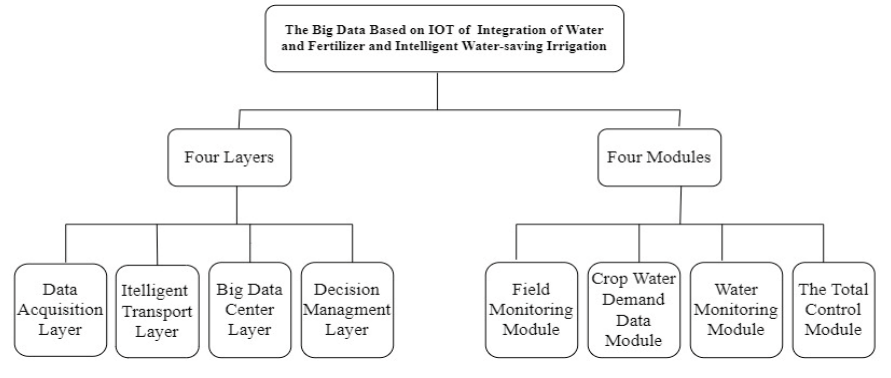
Figure 4. Structure Diagram